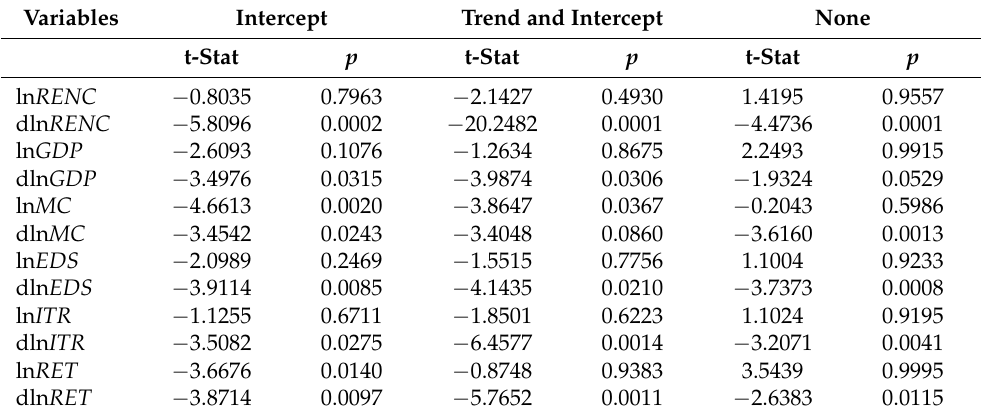
Table 3. Unit root test results for the variables.